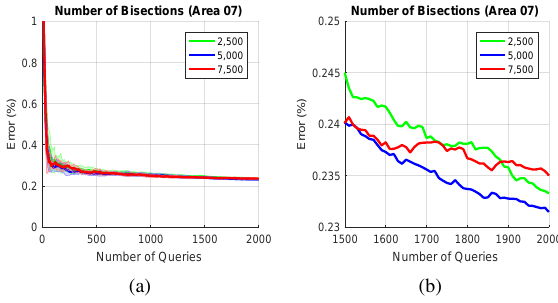
Figure 3. Removing varying fractions of pixels that are considered outliers (largest distance to the mean) has a small but noticeable effect on the classification error. The right figure is a closeup of later iterations. The standard deviations are not shown to provide a less cluttered image.